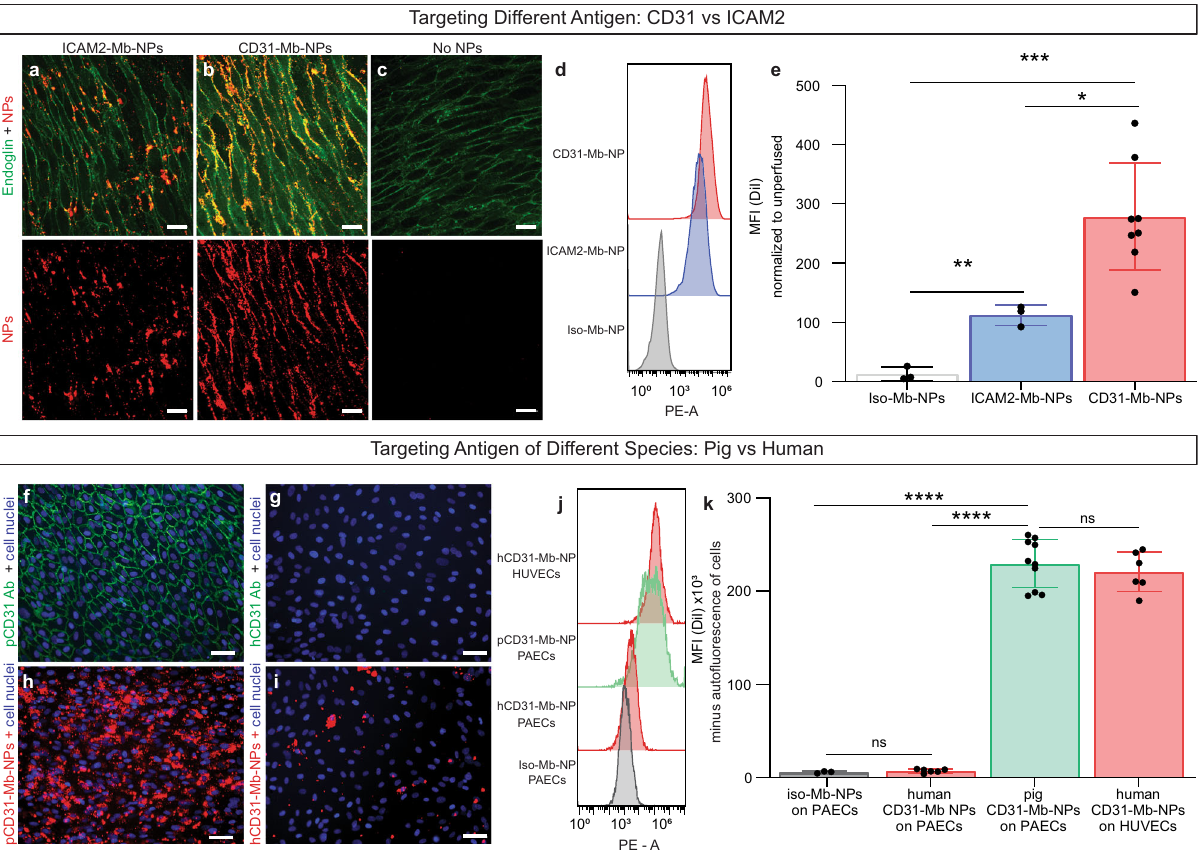
Fig. 3 | The monobody adapter enables adaptability for antibodies targeting different human proteins or endothelial cells from different species. a – c Representative enface confocal images of a section from an isolated umbilical arteryperfused exvivo withICAM2-Mb-NPs( a ),with CD31-Mb-NPs( b )andwithout NPs ( c ). Tissues were stained with anti-CD105-FITC, depicted in green. NPs are depictedinred.Eachimageisdisplayedwithacolormergedviewandaccompanied witharedonlyimagebelow.Scalebarsare20 μ m. d Representative fl owcytometry histogramsand e summarydataofmean fl uorescenceintensity(MFI)of fl uorescent NPs bound to endothelial cells isolated from the umbilical artery after ex vivo perfusion(errorbarsrepresentSD).EachdatapointrepresentstheMFIforasingle vessel ( n =at least three independent experiments). CD31-Mb-NPs data are the same as displayed in Fig. 2K. f – i Representative fl uorescent images of pig aortic endothelial cells (PAECs) incubated with either fl uorescent anti-pig-CD31 antibody